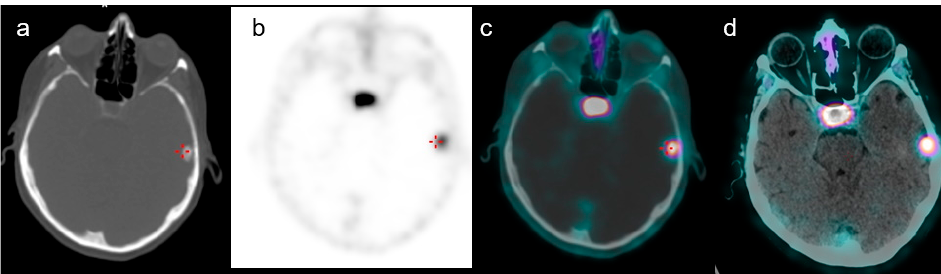
Figure 3. A case of a 66-year-old female with a history of GEP-NET who performed 68 Ga-DOTATOC PET/CT for restaging purposes. Axial CT of PET ( a ), PET ( b ), PET/CT fused images ( c ) and PET/contrast-enhanced CT-fused images ( d ) confirmed the presence of a focal uptake in the left frontal region with a SUVmax of 9. Subsequent histological examination confirmed meningioma.